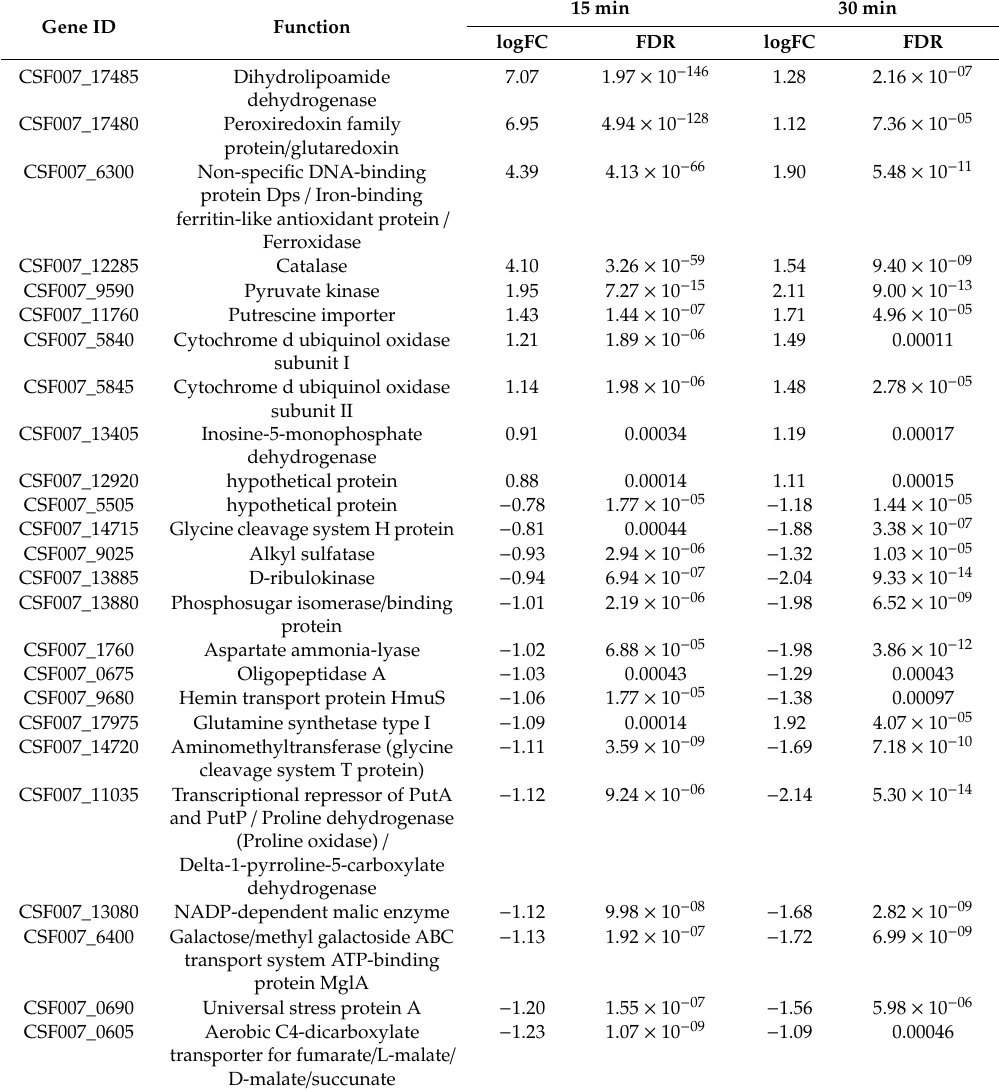
Table 4. Transcriptional response of Y. ruckeri to infection with YerA41. The list of bacterial genes showing significant ( p -value < 0.001) di ff erential expression at both 15 min and 30 min time points compared to non-infected bacteria. The lists of genes di ff erentially expressed at di ff erent time points (15, 30 and 60 min p.i.) are presented in Supplementary Table S3. LogFC; log-ratio of a transcript’s expression values in two di ff erent conditions. FDR; False Discovery